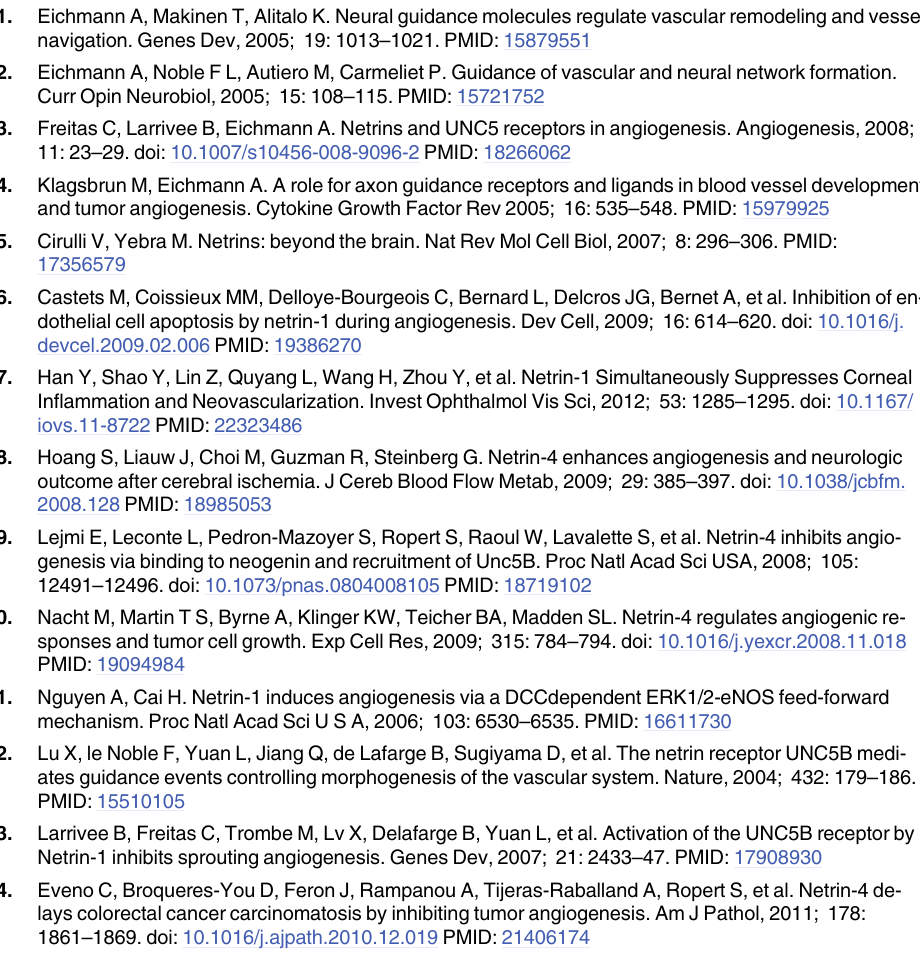
S1 Fig. Effect of different doses of netrin-4 on NV area and inflammatory index induced by alkali-burn rat cornea. (A) 5000 ng/mL netrin-4 inhibited CNV area significantly compared with other groups on day 14 ( (cid:5)(cid:5) p < 0.01). (B) On the 7d, inflammatory index reduced signifi- cantly by 5000 ng/mL netrin-4 ( (cid:5)(cid:5) p < 0.01).